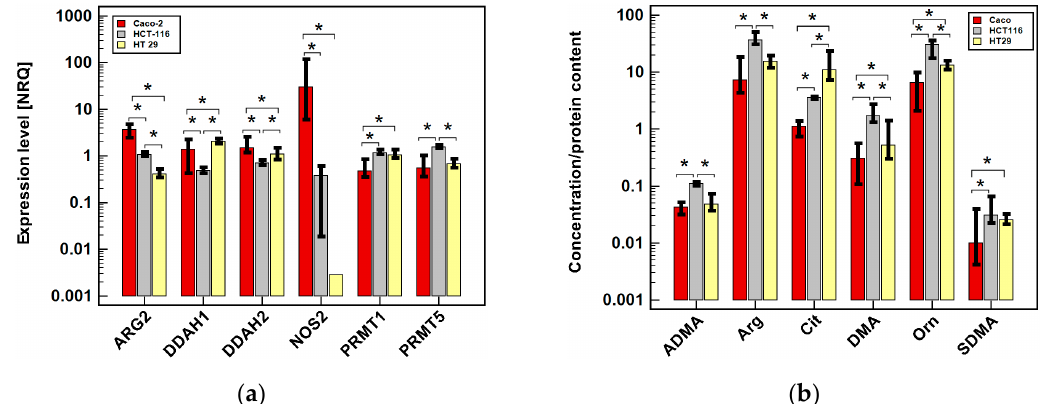
Figure 4. Comparison of arginine/nitric oxide pathway status in untreated colonic adenocarcinoma cell lines in 24-h cultures: ( a ) gene expression normalized to GAPDH ; ( b ) intercellular metabolite concentration adjusted to protein content. Bars represent medians of normalized relative quantities (NRQ) with 95% confidence interval (whiskers). Data were analyzed using Kruskal–Wallis H test. *, significant between-group differences ( p < 0.05); ARG2 , arginase 2; DDAH , dimethylarginine dimethylaminohydrolase; NOS2 , inducible nitric oxide synthase; PRMT , protein methyltransferase; ADMA, asymmetric dimethylarginine; Arg, arginine; Cit, citrulline; DMA, dimethylamine; Orn, ornithine; SDMA, symmetric dimethylamine.